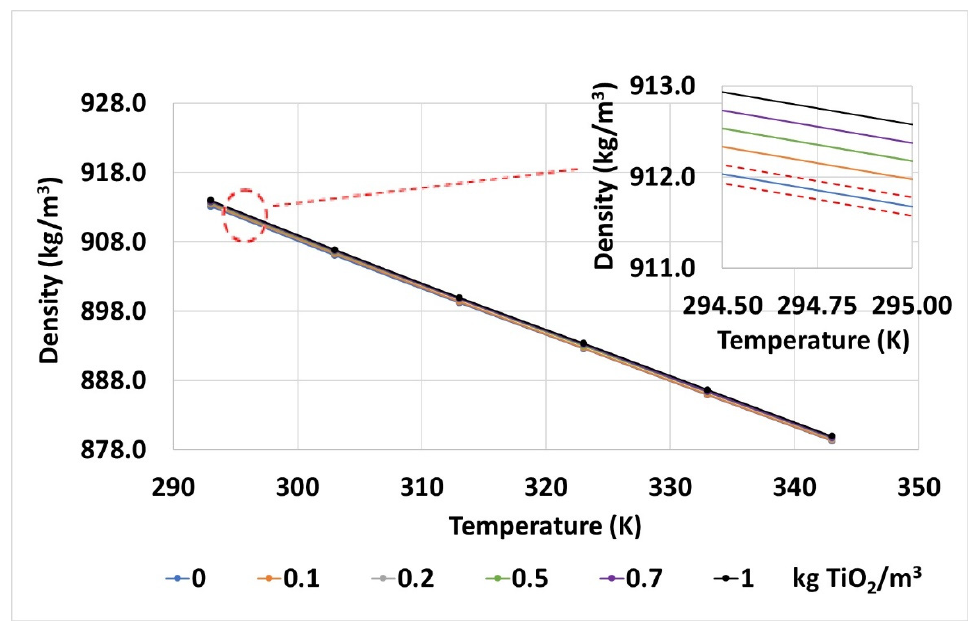
Figure 9. Densities measured for the base fluid and TiO 2 nanofluids at different temperatures. The error gaps of the measurements are also shown by red dashed lines in the inset, top-right corner.